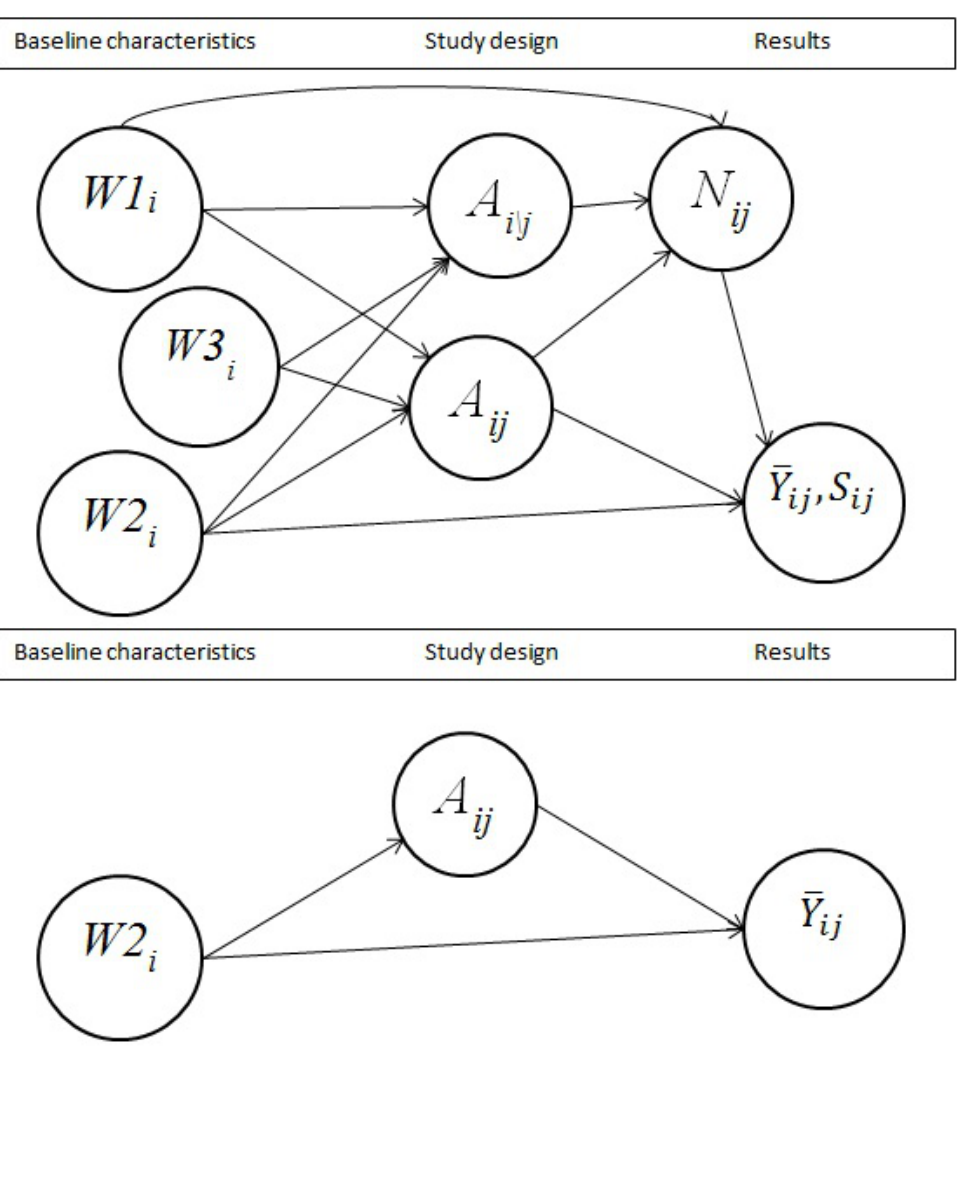
Figure 1: (a) The study-level DAG reflecting the unconfoundedness and time-ordering assumptions made in Section 4.3 and Section 4.2 without assuming independence between the sample mean and standard deviation within a study arm. (b) The simplified DAG that arises from assuming the independence between the sample mean and standard deviation. Here, W  , W  and W  are baseline covariates, A and A are the treatments assigned to arms j and the non- j arm(s), i i i ij i \ j respectively, N is the sample size of arm j , ̄ Y is the mean outcome and S is the estimated standard error of the outcome ij ij ij of arm j